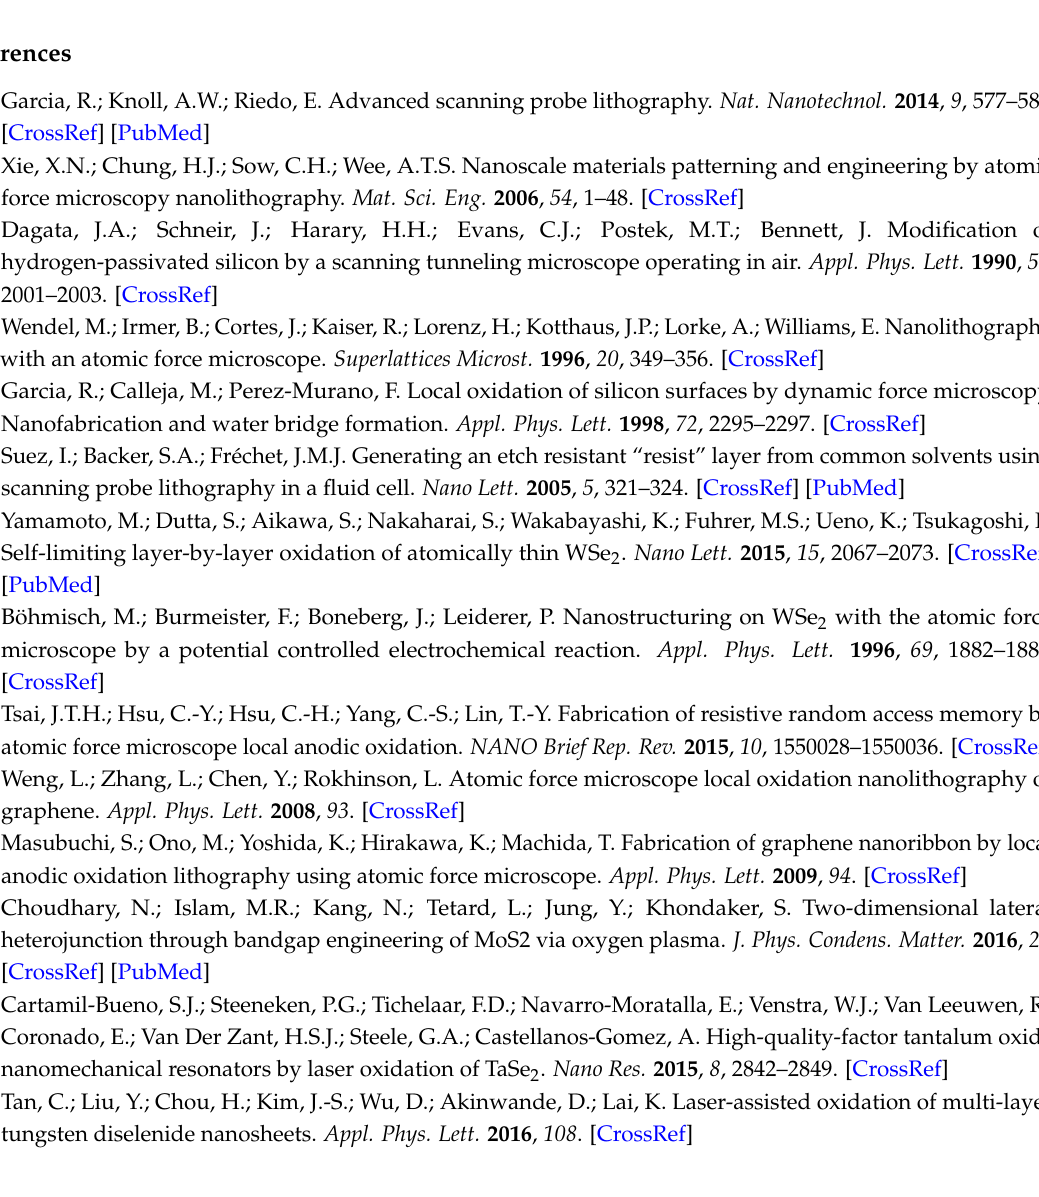
cell refinement (blue). Peaks positions are marked with vertical red lines and the background with a black line. Figure S1.3: 2H-NbS 2 XRPD pattern (green) and unit cell refinement (blue). Inset: Photography of a 2H-NbS 2 crystal. Peaks positions are marked with vertical red lines and the background with a black line. Figure S1.4: TEM characterization of 3R-NbS 2 needles. (a) TEM image of the inspected needle; (b) detail with atomic scale area; and (c) TEM FFT diffraction pattern of (b). Figure S1.5: 2H-NbSe 2 XRPD pattern (green) and unit cell refinement (blue). Peaks positions are marked with vertical red lines and the background with a black line. Figure S2: Sketch describing AFM tip movement during dynamic-tip LON and static-tip LON processes. Figure S3: Etching in thin flakes. Figure S4: AFM topography image of a matrix of 20 × 20 oxide dots onto the NbSe 2 surface by static-tip LON. Image size: 12.5 µ m × 12.5 µ